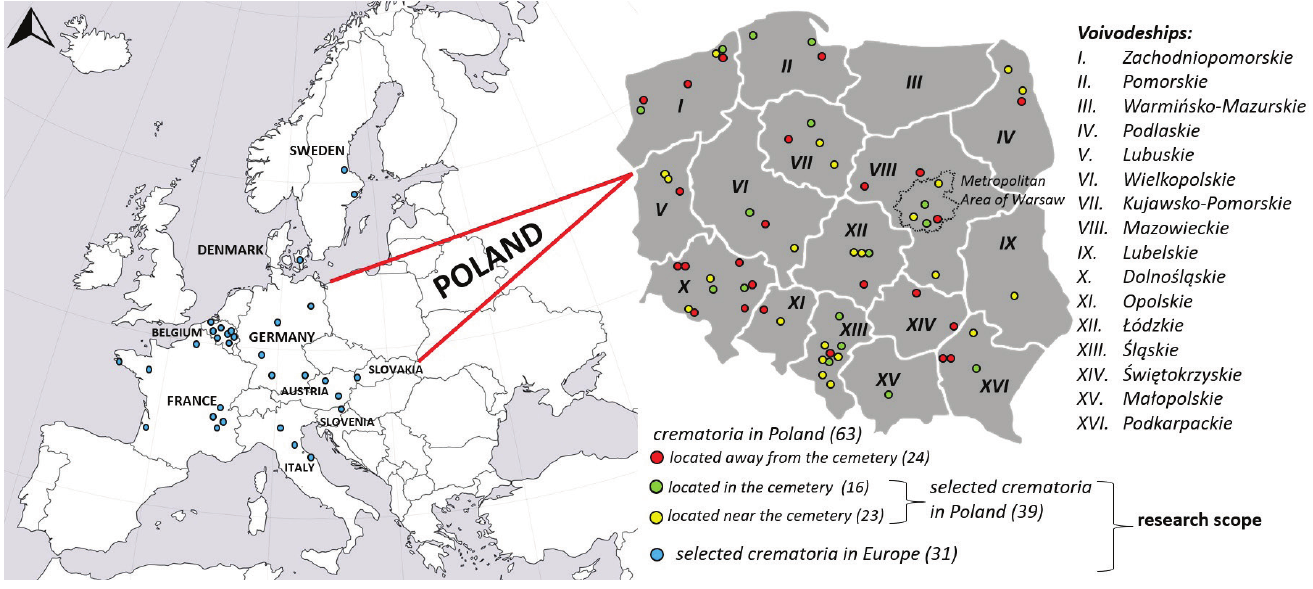
Figure 8. Research scope from Europe (31 objects) and Poland (39 objects). Own